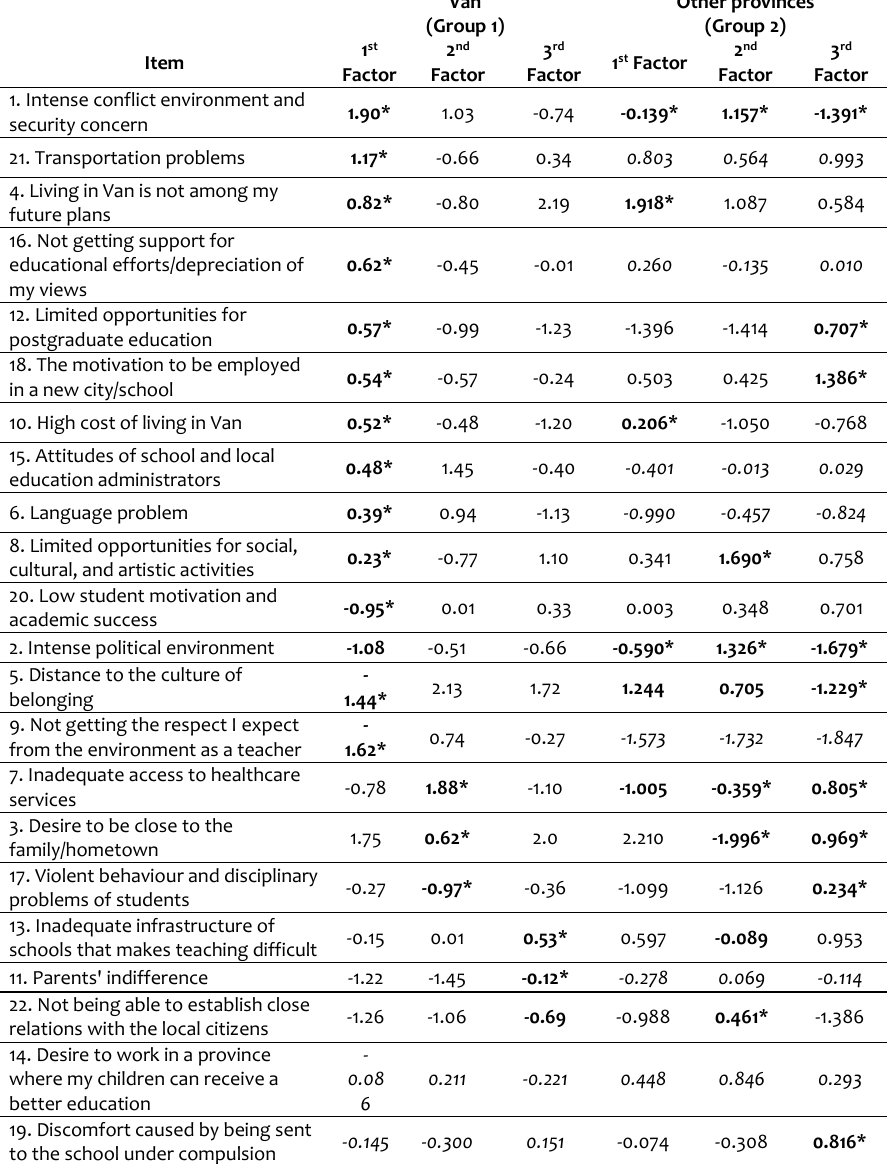
Table 5. Factor-Based Z Score Distributions and Distinctive Items Related to the Reasons for Teacher